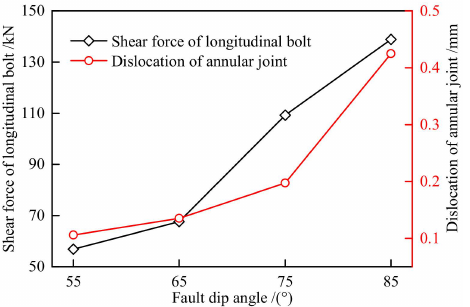
Figure 25. Effect of the fault dip angle on the shear force of longitudinal bolts and annular joints